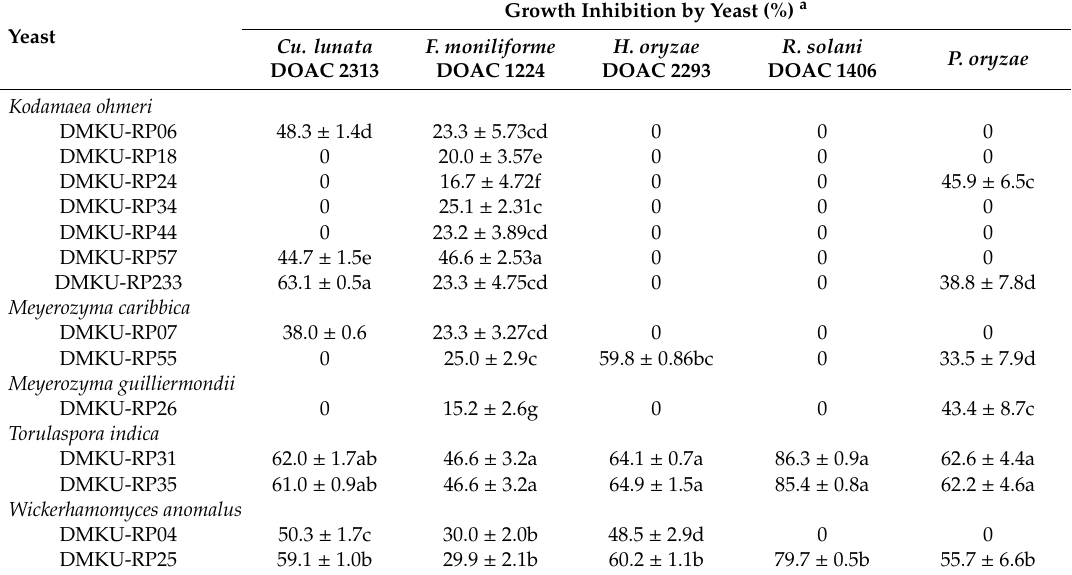
Table 4. Growth inhibition of rice pathogenic fungi by yeasts on potato dextrose agar (PDA) at 25 ◦ C for 7 days.